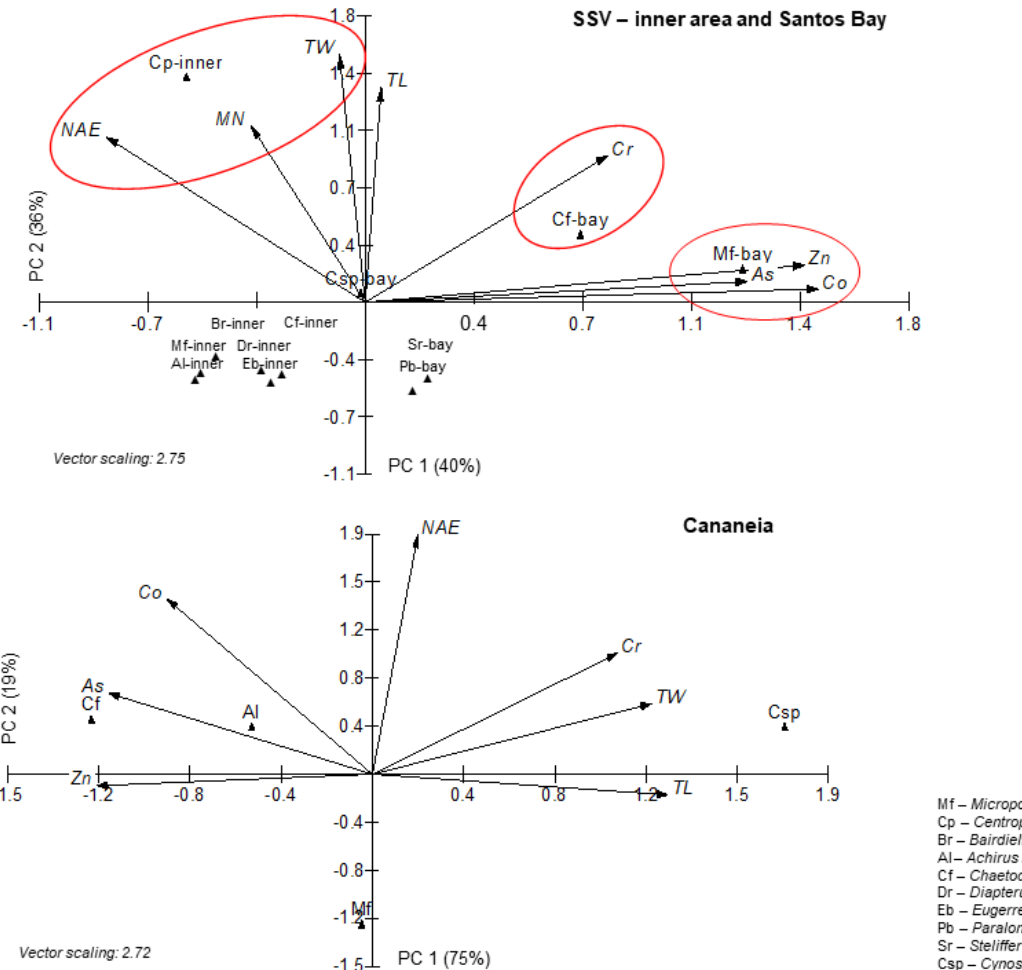
Figure 4 - Multivariate approach by Principal Components Analyses (PCA) of biological variables like total length (tL) and total weight (tW), genotoxic biomarkers as nuclear abnormalities in erythrocytes (ANEs) and micronucleus (MN) and metals and semi- metals (Zn, Co, Cr, As) in different fish species from two sites of the SSV and Cananeia